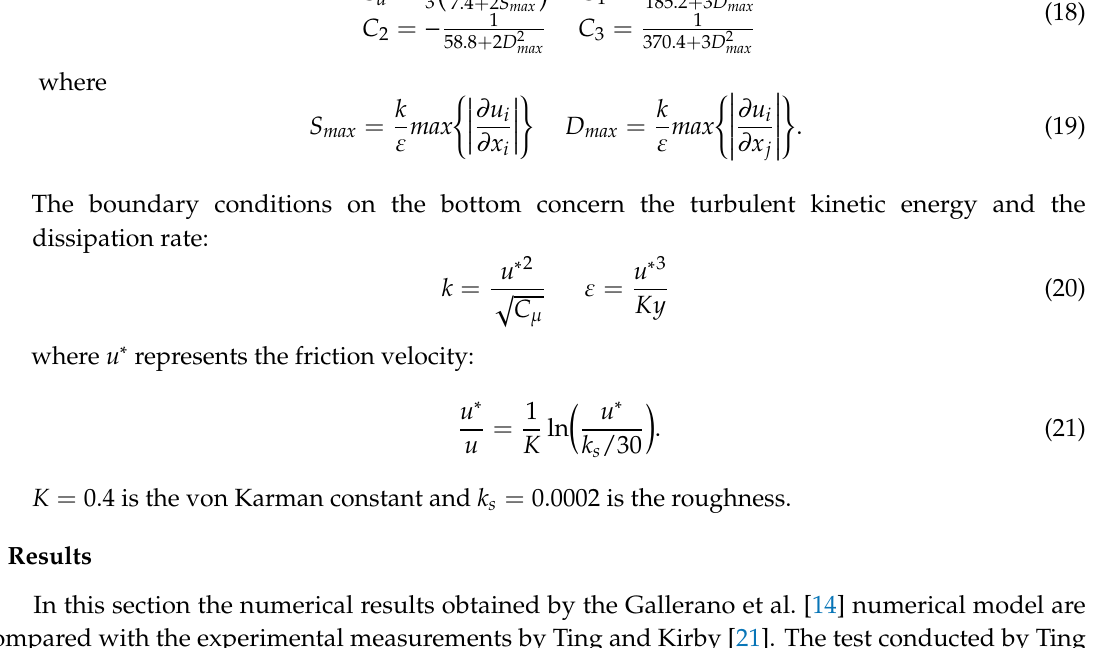
a wetting–drying treatment was